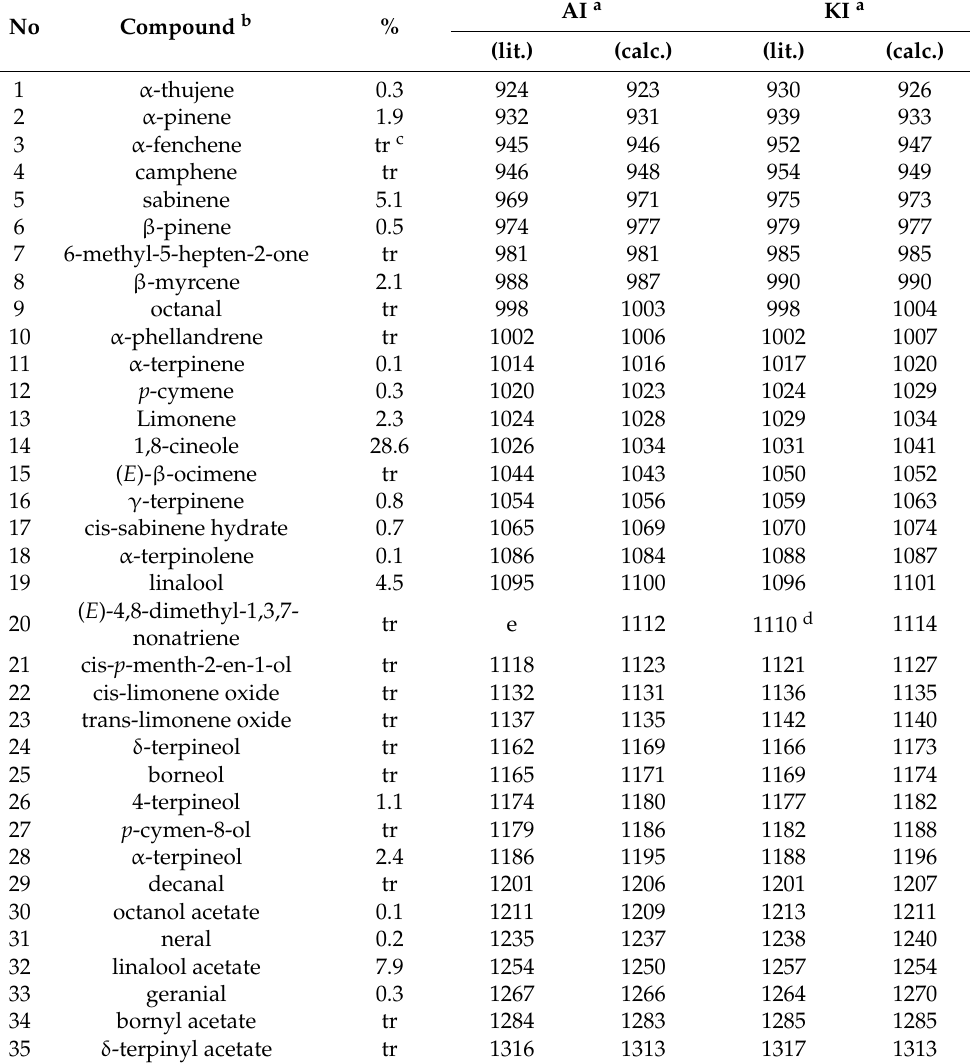
Table 3. Volatile composition of essential oil of E. cardamomum